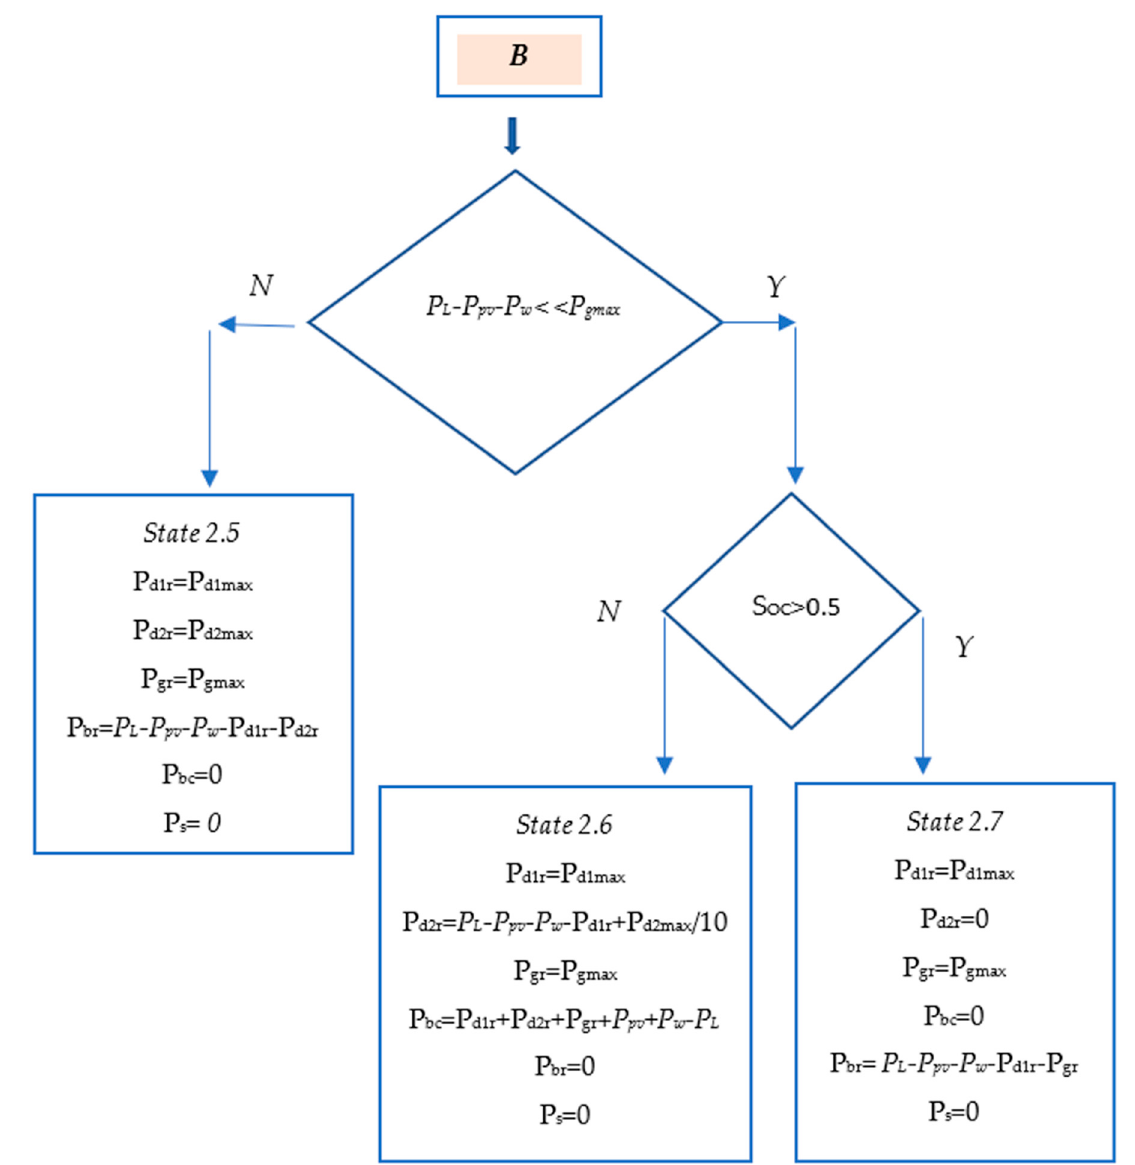
Figure 7. Flow Chart of States and transitions (3 of 3).